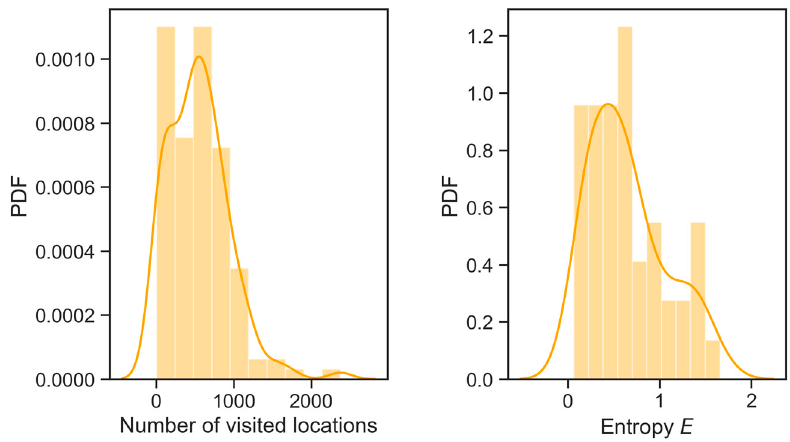
Figure 6. Locations visited and real entropy for ParticipAct data set.